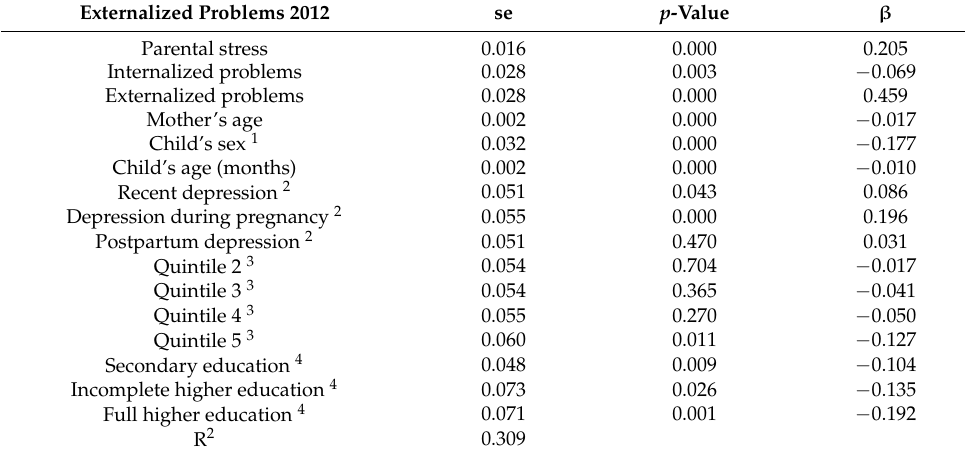
Table 5. Set of predictors of externalized problems.